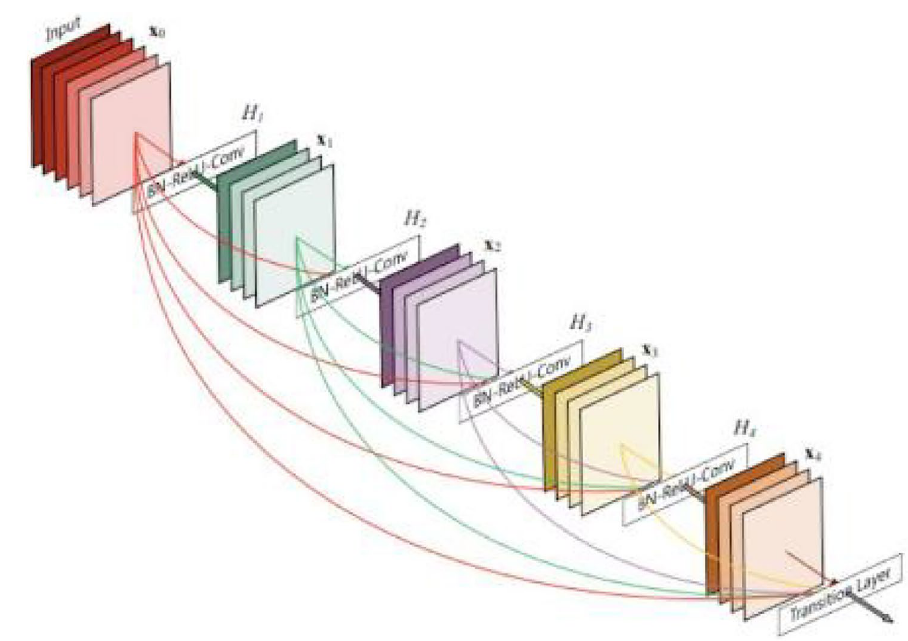
Fig. 5 . DenseNet Base Net-